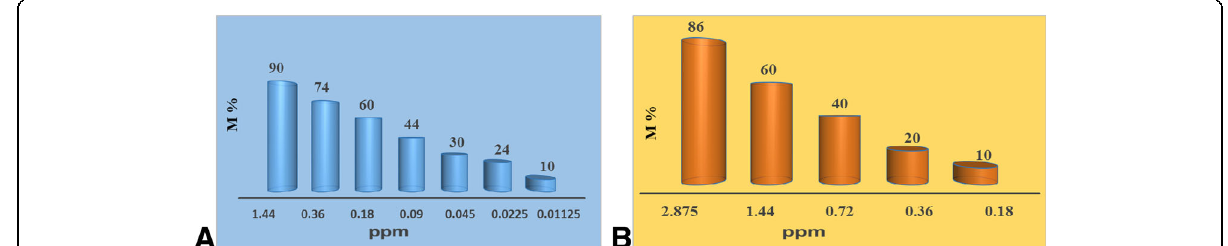
Fig. 6 The mortality percentages of second-instar larvae for AgNPS@P to a laboratory and b field strains of Spodoptera littoralis